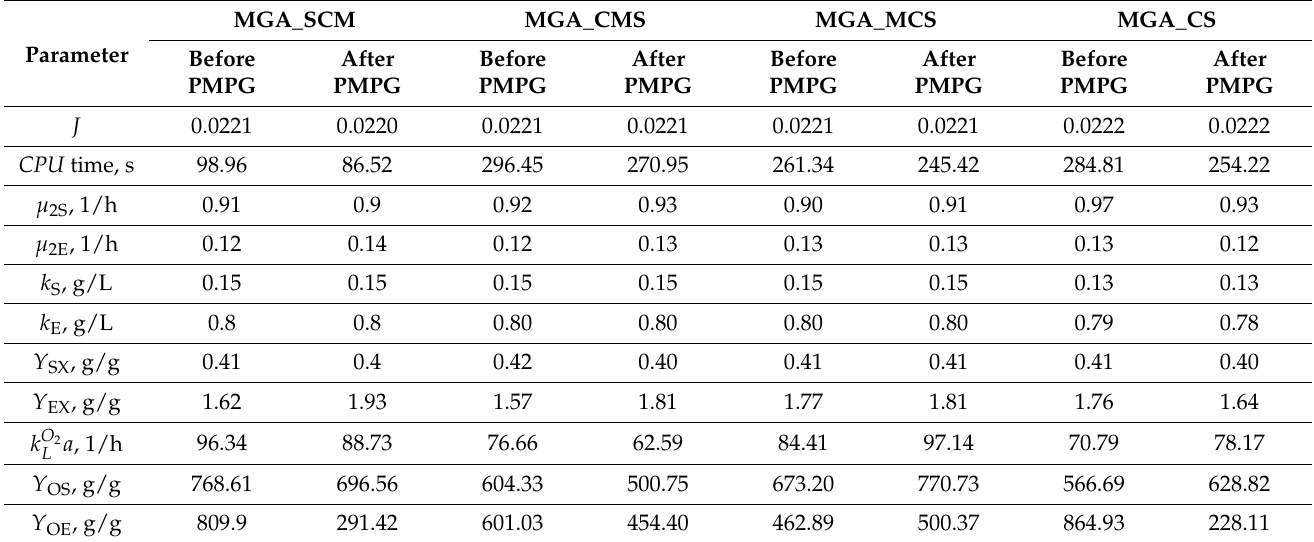
Table 5. Model parameters’